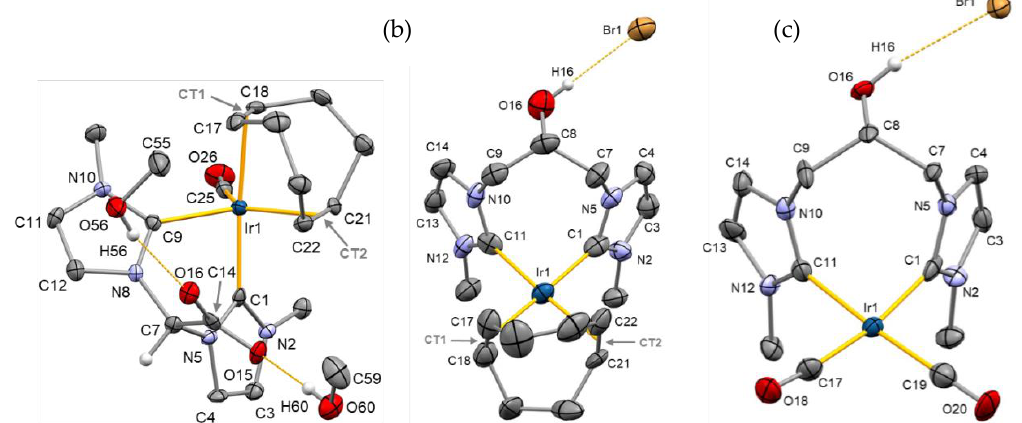
Figure 2. ORTEP plot of 2 in 2 · 2 CH 3 OH ( a ), 4 in 4 · 1.75 CH 2 Cl 2 ( b ), and 5 in 5 · CH 2 Cl 2 ( c ). Thermal ellipsoids are at 50% of probability. For clarity, most hydrogen atoms are omitted. CT, the centroid of olefinic carbons. Hydrogen bond parameters (Å , deg): 2 : O(56)-H(56)···O(16): O(56)-H(56) 0.84, H(56)···O(16) 1.90, O(56)···O(16) 2.714(6), O(56)-H(56)-O(16) 162.4; O(60)-H(60)···O(15): O(60)-H(60) 0.84, H(60)···O(15) 1.87, O(60)···O(15) 2.714(6) O(60)-H(60)···O(15) 176.3. 4 : O(16)-H(16)···Br(1): O(16)-